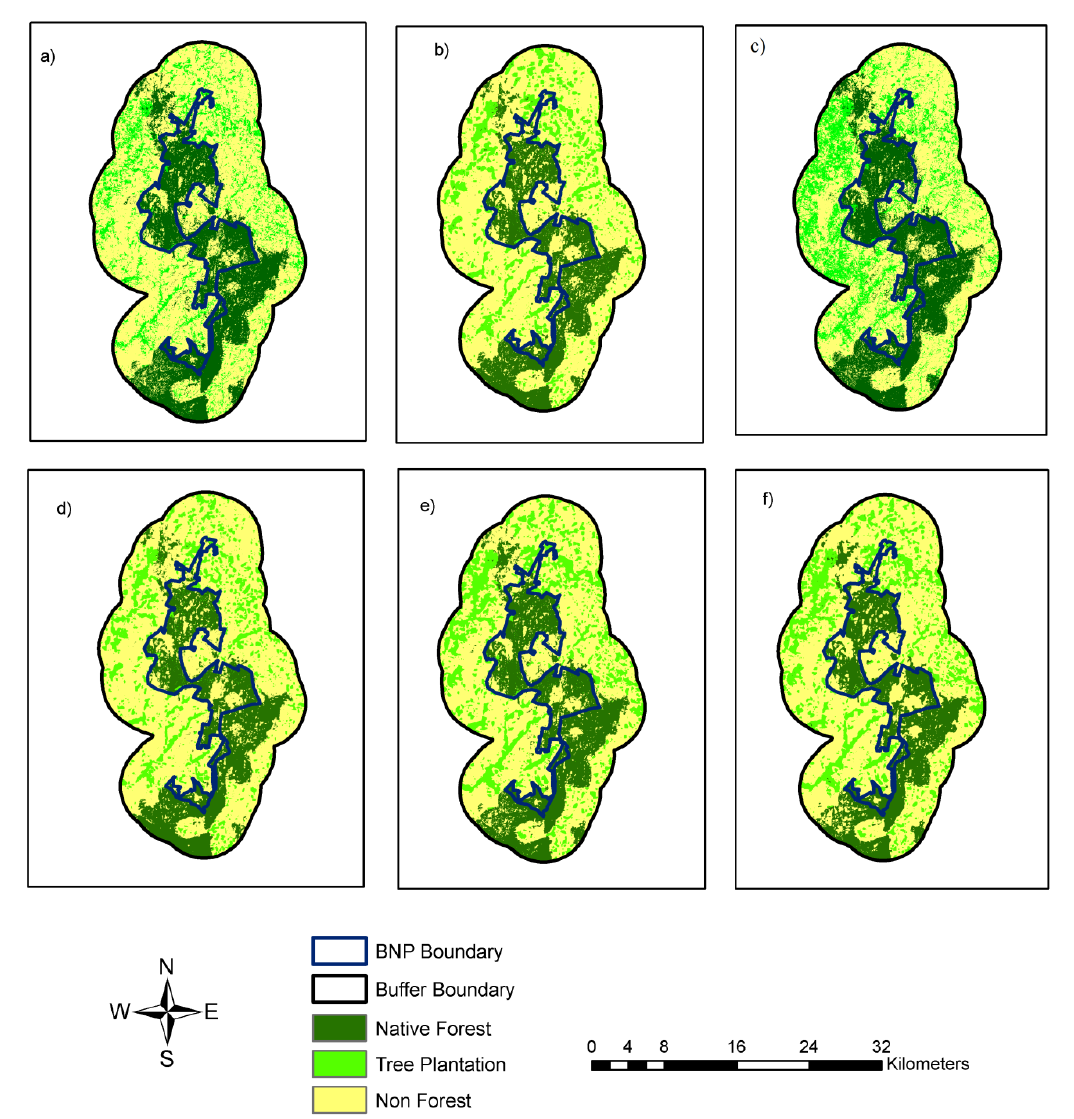
Figure 4. Land covers for the study area with Park boundary and a buffer of 5 km from the park boundary. ( a ) 1999 (See Table 4 for area) predicted land-covers for a given year is denoted by